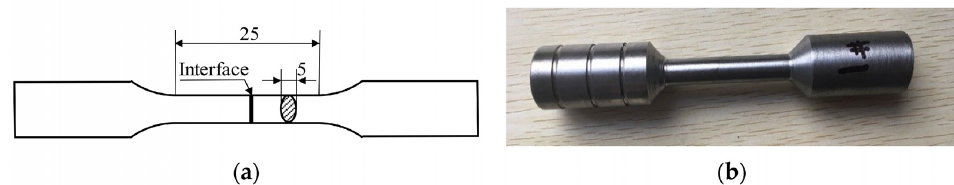
Figure 6. Samples for tensile tests: ( a ) schematic drawing and ( b ) physical